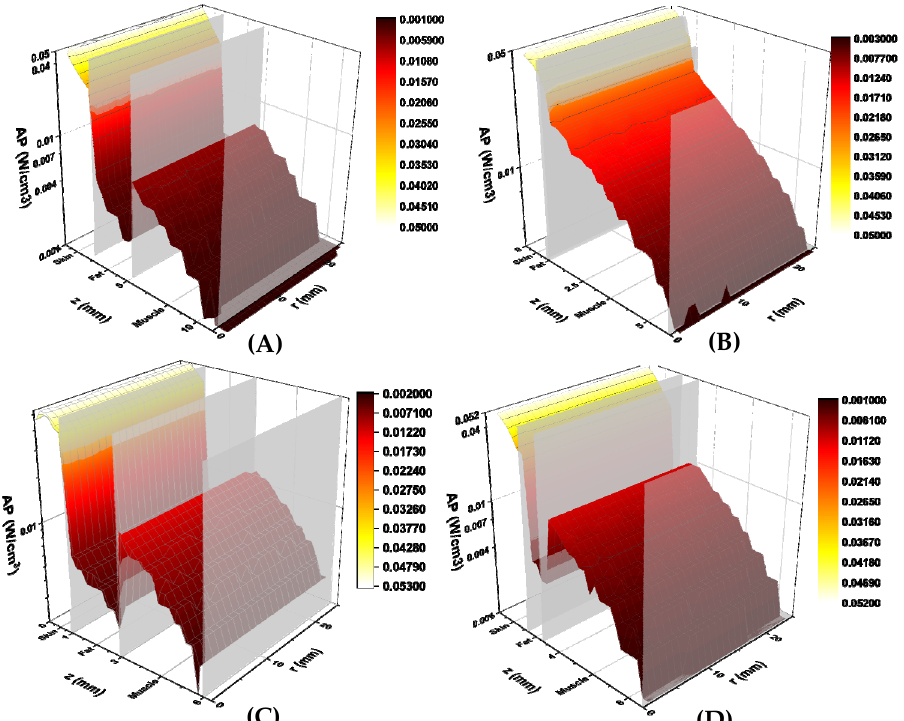
Figure 5. Simulated absorbed power (W/cm 3 ) for volunteers 1 ( A ), 2 ( B ), 3 ( C ), and 4 ( D ). Calculated absorbed power are displayed on the vertical axis, tissue depth (mm) is displayed on the z axis, and lateral tissue radius (mm) is displayed on the r axis. Tissue boundaries are labelled on the tissue depth axis. Graphs are colour-coded based on absorbed power, with yellow illustrating higher power and red lower power.